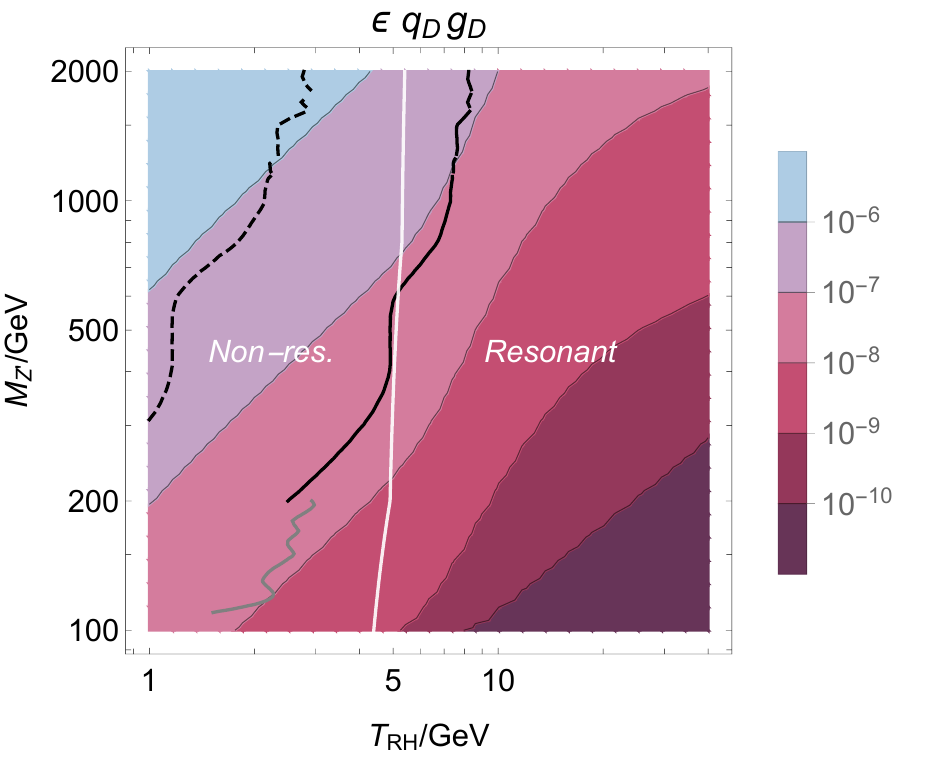
Figure 5 . Value of (cid:15)g D q D needed to obtain the measured relic abundance as a function of m Z 0 and T RH for m X = 1 GeV. The white curve separates regions of parameter space where different contributions dominate dark matter production, as specified by the labels. We also show bounds from LHC searches for a heavy Z 0 decaying into a lepton pair: the grey curve represents the CMS bound [37]; the black curves represent the stronger bound between the ATLAS [38] and CMS [39] searches. For the LHC bounds, we fix g D q D = 3 × 10 − 6 (solid curves) and 3 × 10 − 5 (dashed